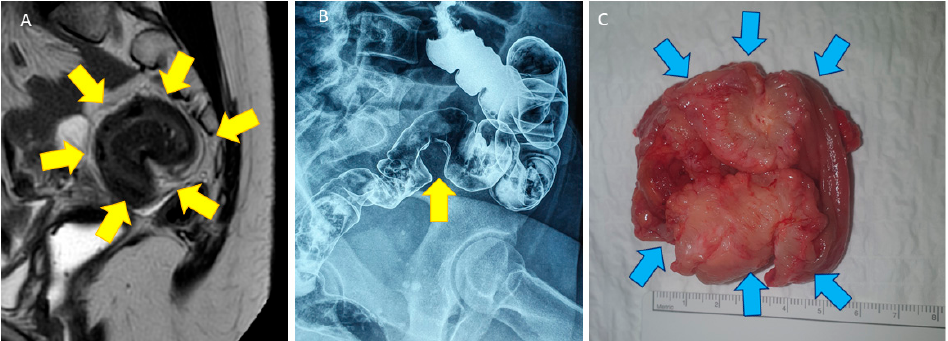
Figure 6. ( A ) Pelvic MRI with a T2-weighted sagittal view of a DE nodule (yellow arrow) infiltrating the sigmoid wall, leading to severe stenosis and aspect of an omega loop. ( B ) Double-contrast bar- ium enema with infiltration of the muscularis of the sigmoid wall in a stenotic DE nodule (yellow arrows). ( C ) Very short sigmoid resection specimen showing a severe stenosis due to DE nodule (blue arrow).